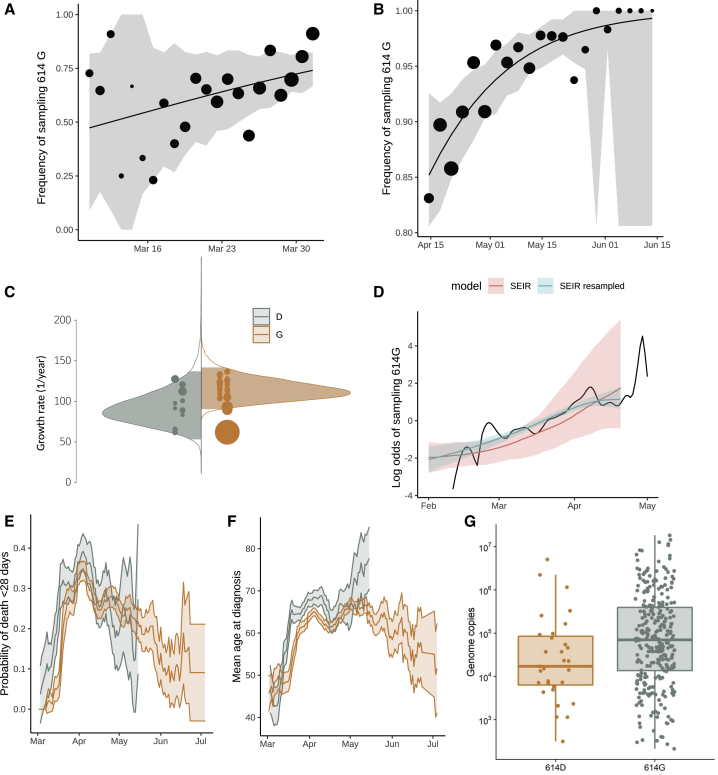
Relative Frequency of Spike 614D and G over Time, Phylodynamic Growth Rates and Comparison of Clinical Severity MetricsRelative frequency of spike 614D and G over time (A and B), phylodynamic growth rates (C and D), and comparison of clinical severity metrics (E–G).(A) Frequency of sampling spike 614G over time for clusters sampled during exponential growth phase. The size of points represents the number of samples collected on each day. The line and shaded region showed the maximum likelihood estimate (MLE) and confidence interval fit of the logistic growth model.(B) As in (A) but including samples during a period after April 15 during a period of epidemic decline.(C) Distribution of exponential growth rate for spike 614G (brown) and 614D (gray) in units of 1/year. Solid areas span the 95% credible interval. Points indicate the rates estimated for specific clusters and are sized by the number of sequences in that cluster.(D) Log odds of sampling spike 614G in London comparing empirical values (black line) and estimates based on the phylodynamic susceptible-exposed-infectious-recovered (SEIR) model (shaded regions). The green shaded region shows estimates making use of both genetic data and sample frequency data.(E) The probability over time of fatal outcome within 28 days of diagnosis among UK patients with sequence data that can be matched to clinical records. Shaded regions show 95% confidence region of a 7-day moving average. Points with fewer than 20 observations are omitted.(F) Moving average of age among samples included in (E).(G) Viral load (real-time qPCR mean genome copies) estimated using SARS-CoV-2 RNA strands from 31 614D (614D) and 290 614G samples.